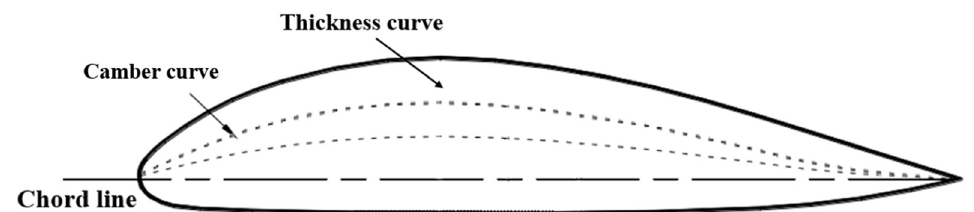
Figure 3. Parametric airfoil profile.